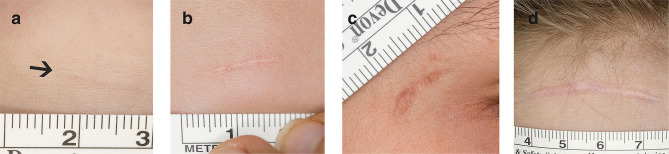
Exemplary range of photographs scored with the POSAS. This is a compilation of four photographs of facial lacerations, scored by one of the online observers using the POSAS and merely serves for a better illustration [POSAS Observer scale, overall opinion = (a) 1, (b) 3, (c) 5, and (d) 7].